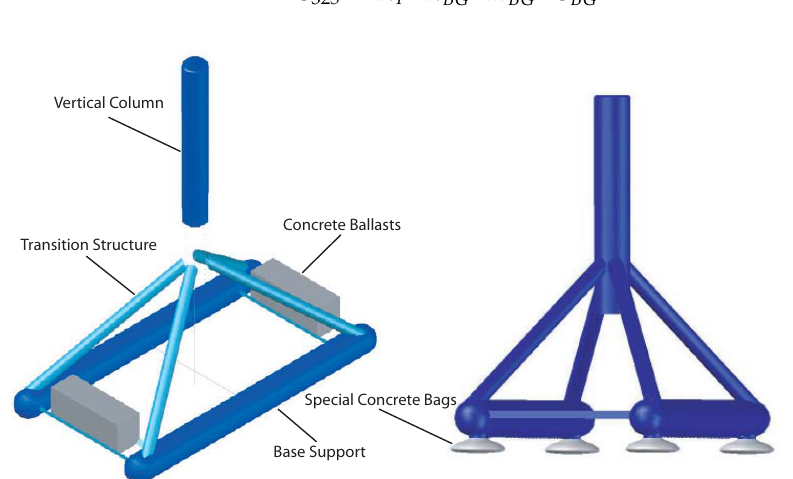
Figure 3. Supporting TEC